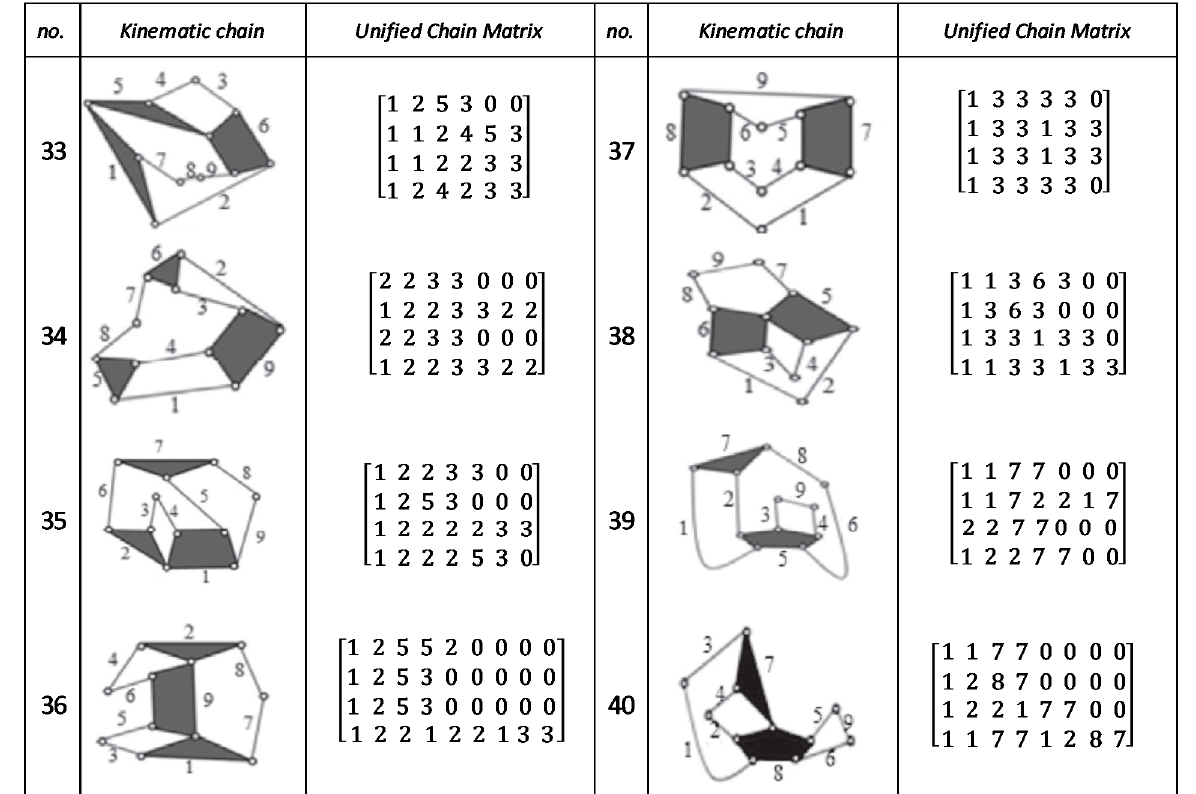
Figure A4. Unified chain matrix, UCM, for all 9 links and 2-DOF KCs with simple joints [40].